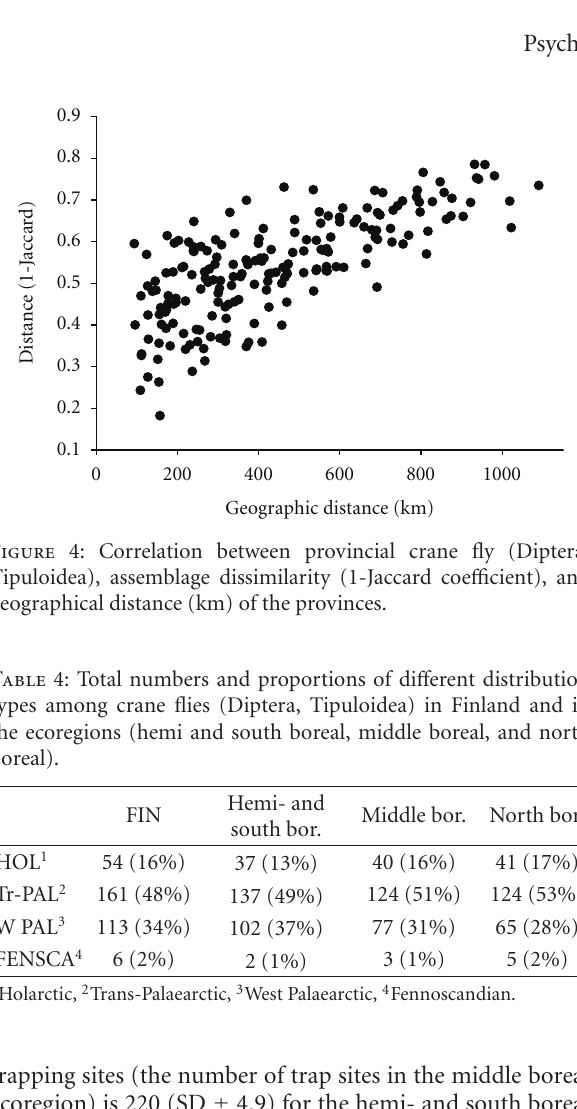
Jaccard distances ranged from 0.182 (Ab-Ta) to 0.786 (Le- Ka), the average being 0.54 (SD ± 0.121).